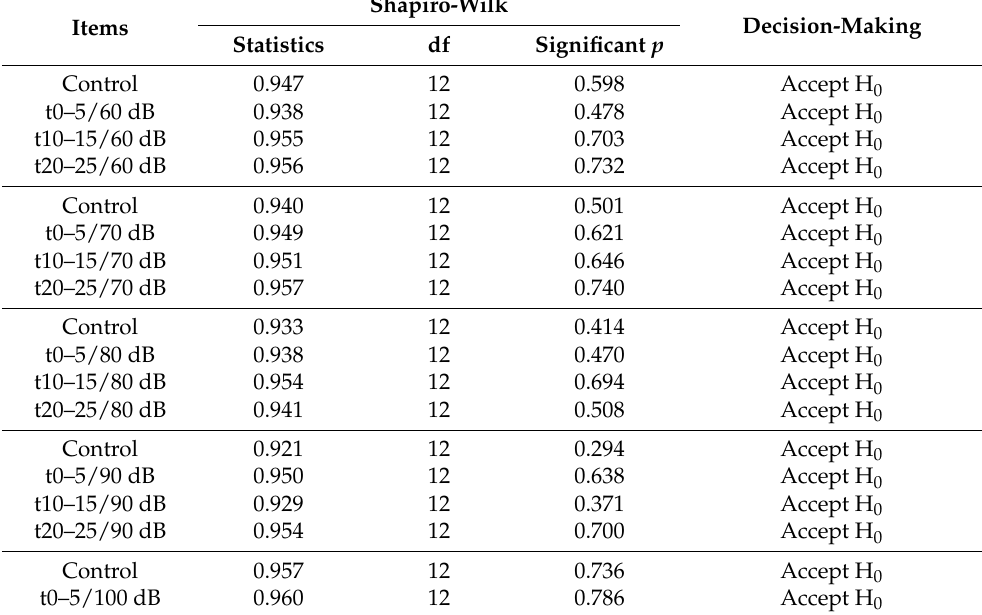
Table 3. Normality test results of skin